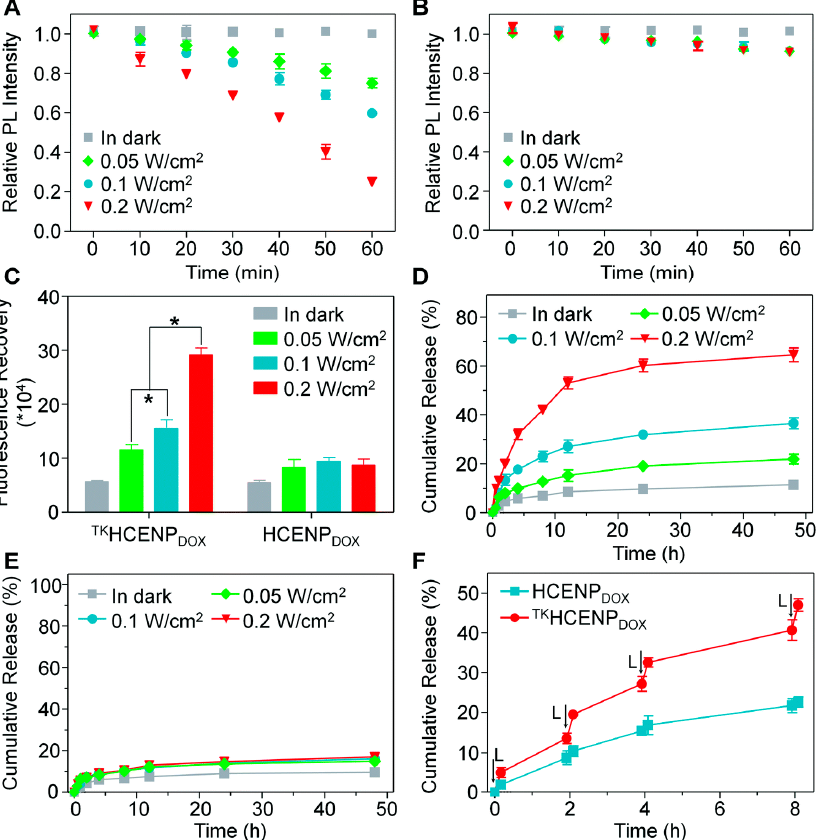
Figure 17. Fluorescence quenching of NR from TK HCENP NR ( A ) and HCENP NR ( B ) in aqueous solution after light stimulation at pH 7.4. ( C ) Fluorescence recovery of DOX from TK HCENP DOX and HCENP DOX after light stimulation at pH 7.4. The cumulative release of DOX from TK HCENP DOX ( D ) and HCENP DOX ( E ) upon 660 nm laser irradiation at di ff erent power densities for 30 min. ( F ) Laser-stimulated pulsed release of DOX from HCENP DOX and TK HCENP DOX . The samples were irradiated with a 660 nm laser (0.2 W cm − 2 ) for 10 min at di ff erent time points indicated by the arrows. TK HCENP NR refers to light activated nano-carrier with thioketal linkers containing Nile red dye and HCENP NR refers to without thioketal linkers containing Nile red. TK HCENP DOX refers to the same as before containing DOX drug. From [115].